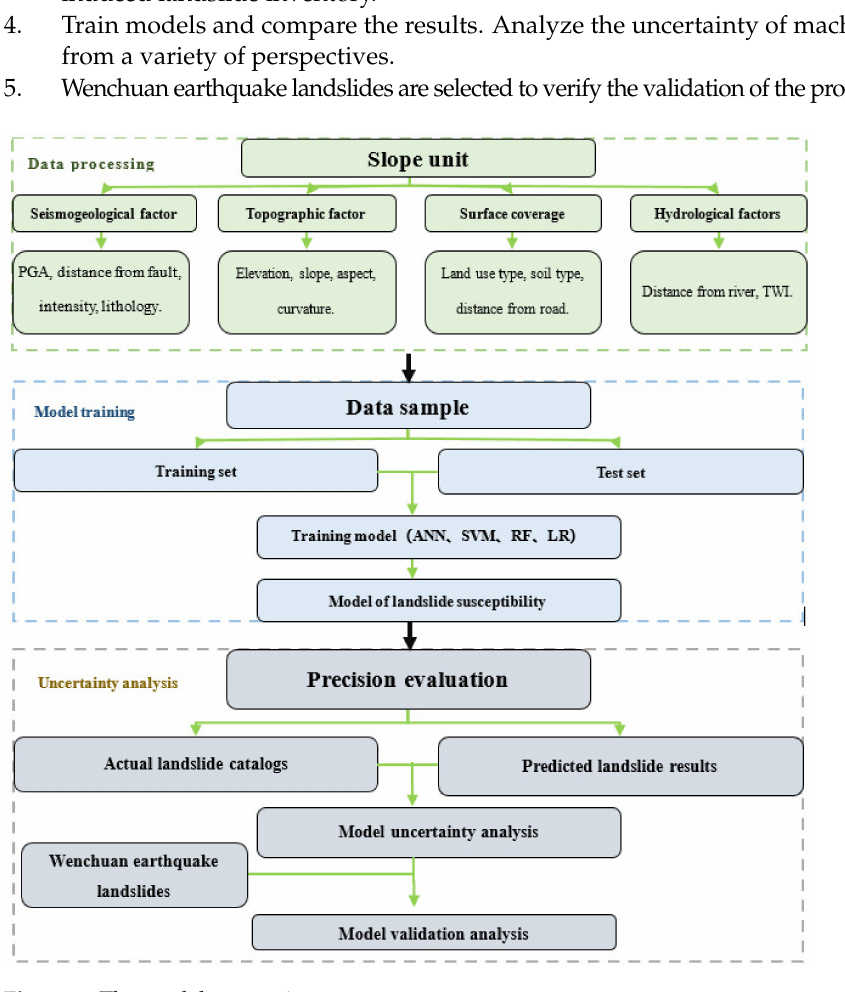
Figure 2. The model uncertainty assessment